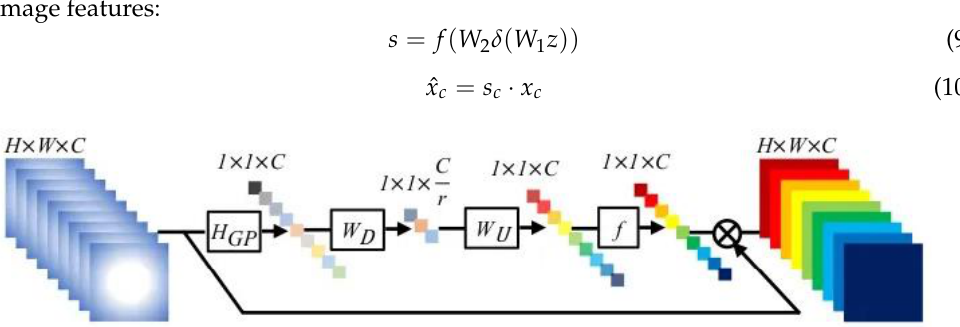
Figure 6. Feature map attention mechanism.